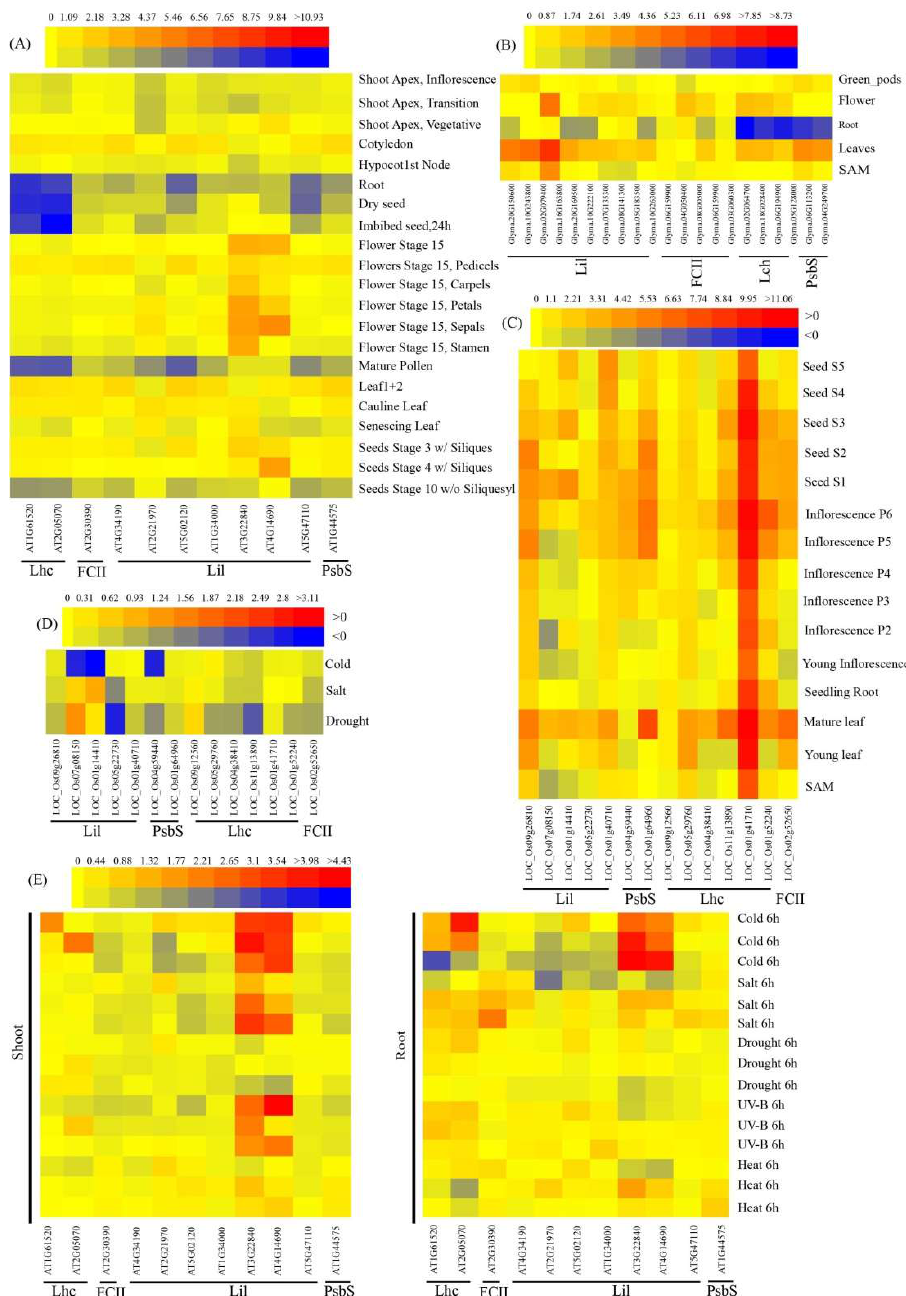
Figure 9. Expression profiles of LHC genes in representative species: ( A – C ) Spatial and temporal expressions of LHC genes from Arabidopsis , Glycine max (soybean), and Oryza sativa (rice); ( D , E ) Expression of LHC genes under different stress treatments.